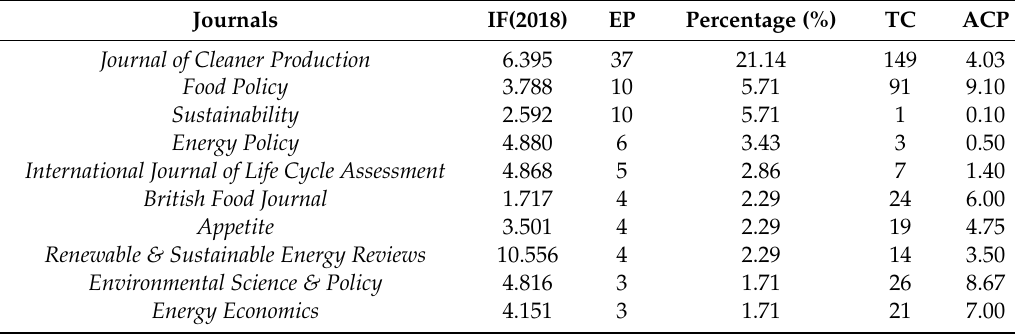
Table 3. Top 10 journals with the most published articles.